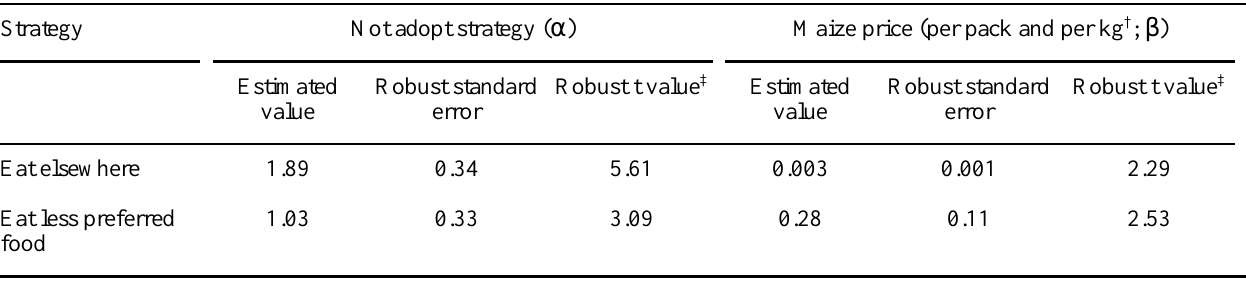
Table 6. Binary logit model for the significant strategy choice under increasing maize price per pack and per kg. ‘Eat elsewhere’ was a significant strategy choice when the value per pack varied, whereas ‘eat less preferred food’ was significant when the price per kg